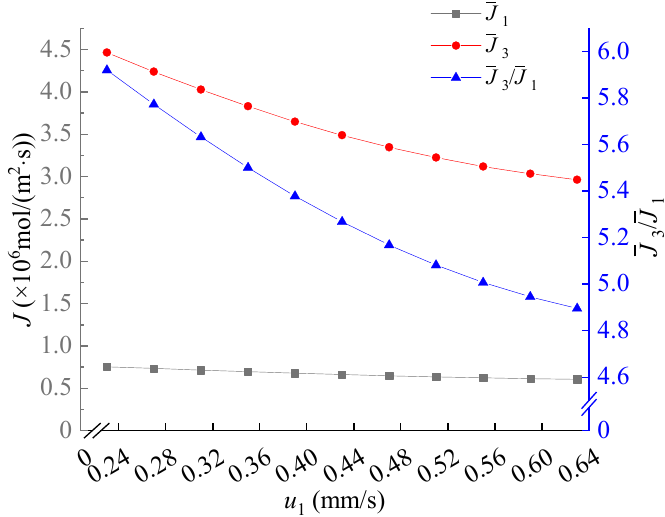
Figure 7. The dependence of the average flux of Li + , the average flux of Mg 2+ and the Mg 2+ /Li + flux ratio on u 1 . Values of other parameters are: V = 30V T , u out = 0.5 mm/s, u 2 = 1 mm/s, 18 μ m ≤ y ≤ 31.5 μ m, x = 96 μ m.